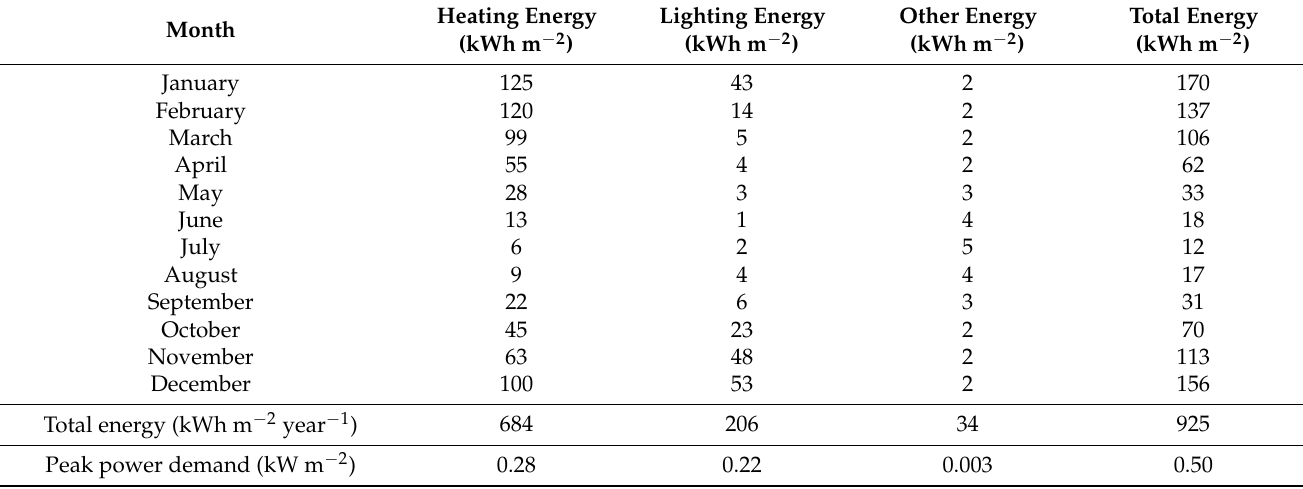
Table 2. Greenhouse energy consumption and peak